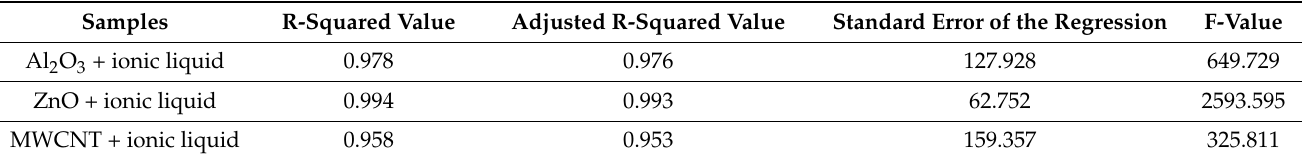
Figure 9. Three-dimensional analysis of MWCNT suspensions. Table 5. Statistical data on polynomial regressions. Table 5. Statistical data on polynomial